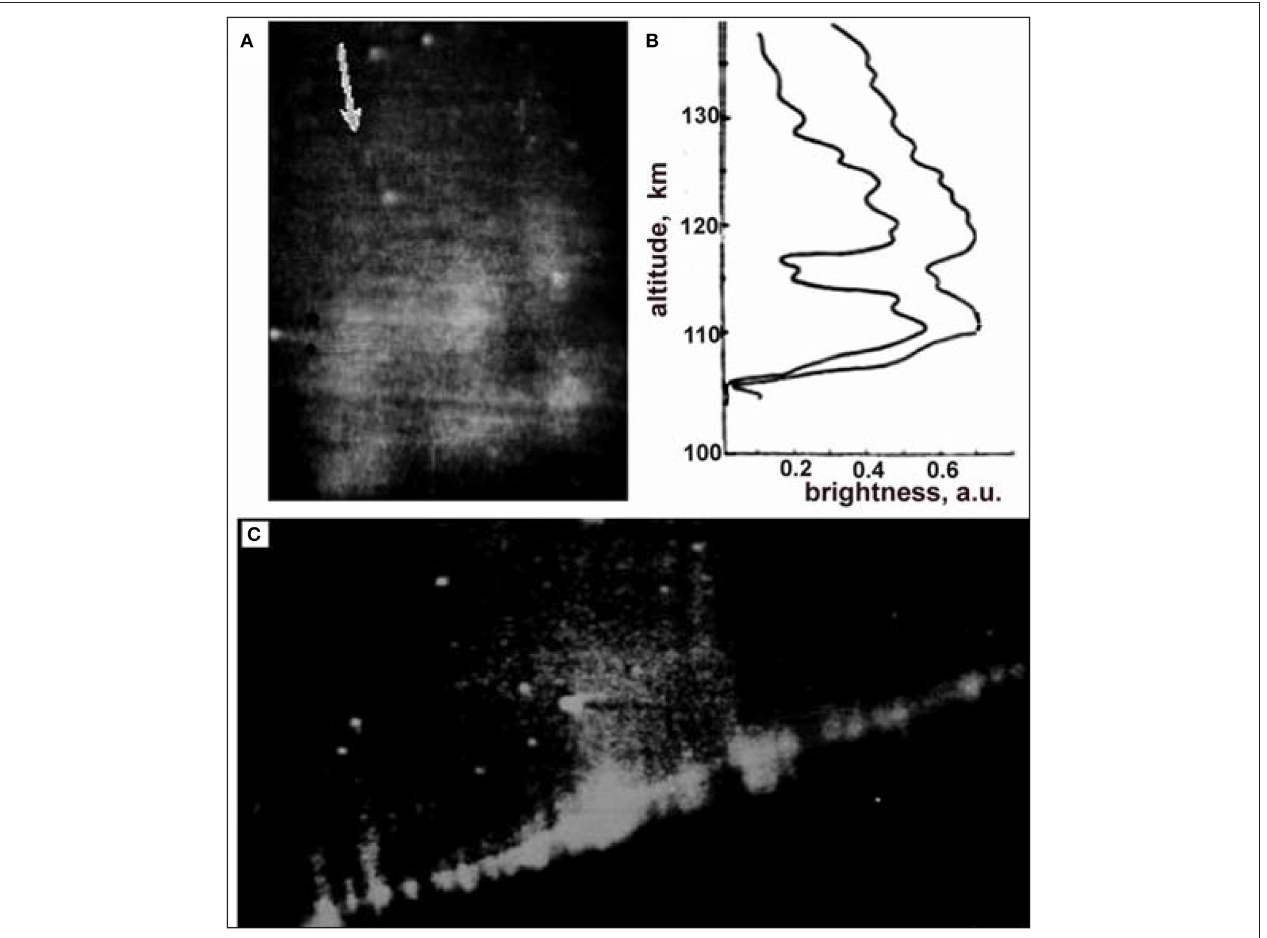
FIGURE 14 | (A) Auroral rays along the magnetic field indicated by the arrow and (B) their luminosity profiles. Adapted from Dzyubenko et al. (1980). (C) A rayed arc with the sharp upper boundary. After Hallinan et al. (1985). Reprinted by permission from the American Institute of Physics and American Geophysical Union.